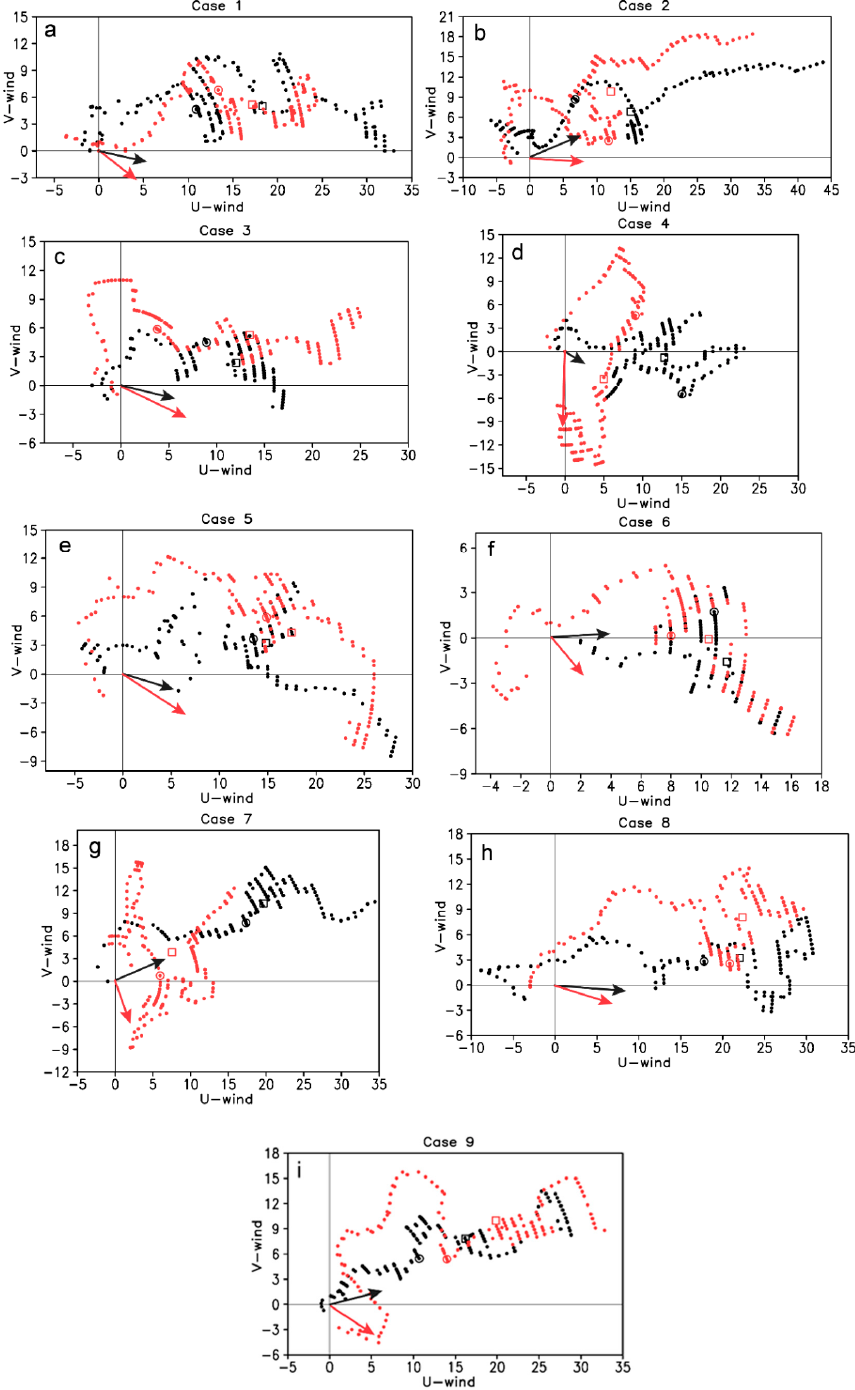
Figure 5. Hodographs of radiosonde stations (a: “59265”; b: “59265”; c: “59293”; d: “59280”; e: “59265”; f: “59265”; g: “59293”; h: “59265”; i: “59293”) before (black) and after (red) MCSs turned to move southeastward ( a – i : cases 1–9). The times for the black hodographs in a – i are 0800 BT 11 April 2012, 2000 BT 5 April 2014, 0800 BT 8 May 2014, 2000 BT 22 May 2014, 2000 BT 30 April 2015, 2000 BT 4 May 2015, 0800 BT 4 April 2016, 2000 BT 14 April 2016 and 0800 BT 19 April 2017, respectively, and the times for the red hodographs are 12 h later. The open circles indicate the wind vector (units: m s − 1 ) at 3.5 km and the open rectangles indicate the mean wind vector (units: m s − 1 ) between 850 and 300 hPa. The vectors plotted on the hodographs indicate the motion vectors of